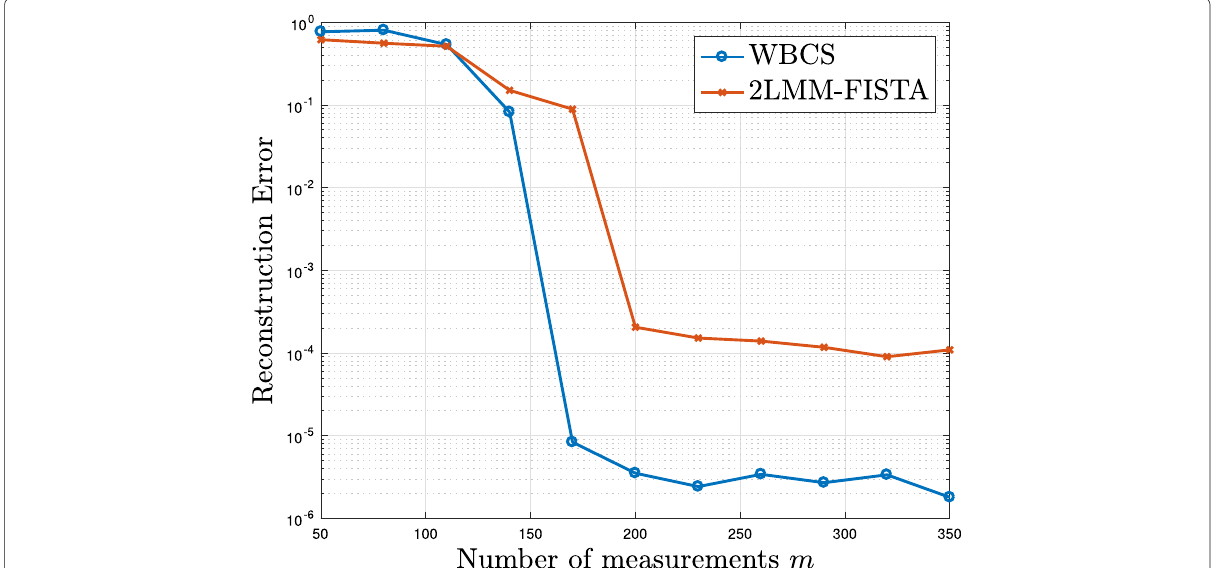
Fig. 12 Comparison between WBCS and 2-LMM: reconstruction error of a signal with n = 512 and k = 63 as a function of number of